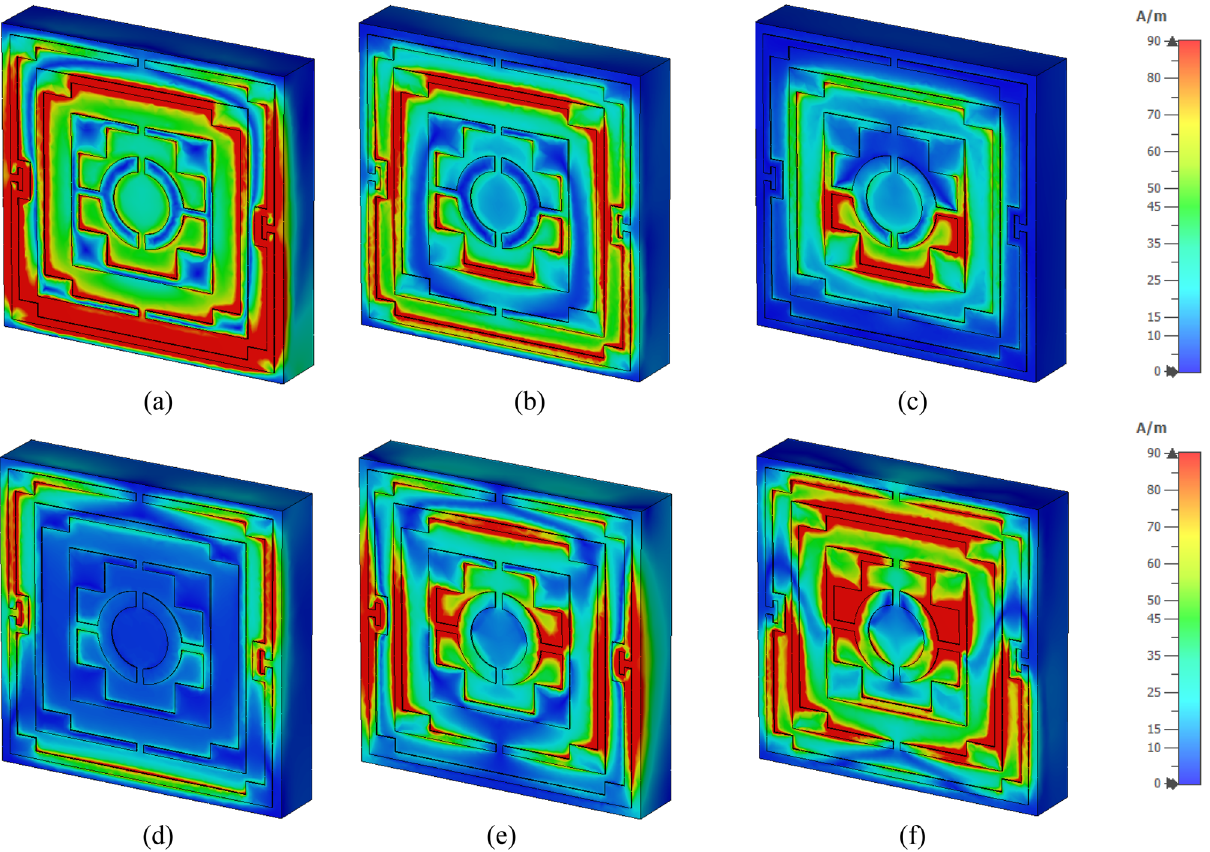
Figure 5. H field distribution of the unit cell ( a ) 2.38 GHz, ( b ) 4.24 GHz, ( c ) 5.98 GHz, ( d ) 9.55 GHz, ( e ) 12.1 GHz, and ( f ) 14.34